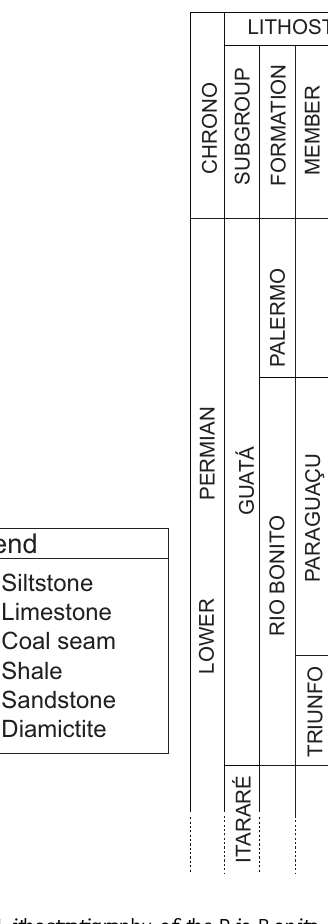
Fig. 2 – Lithostratigraphy of the Rio Bonito Formation in the Figueira region. Modified from: Morrone and Daemon